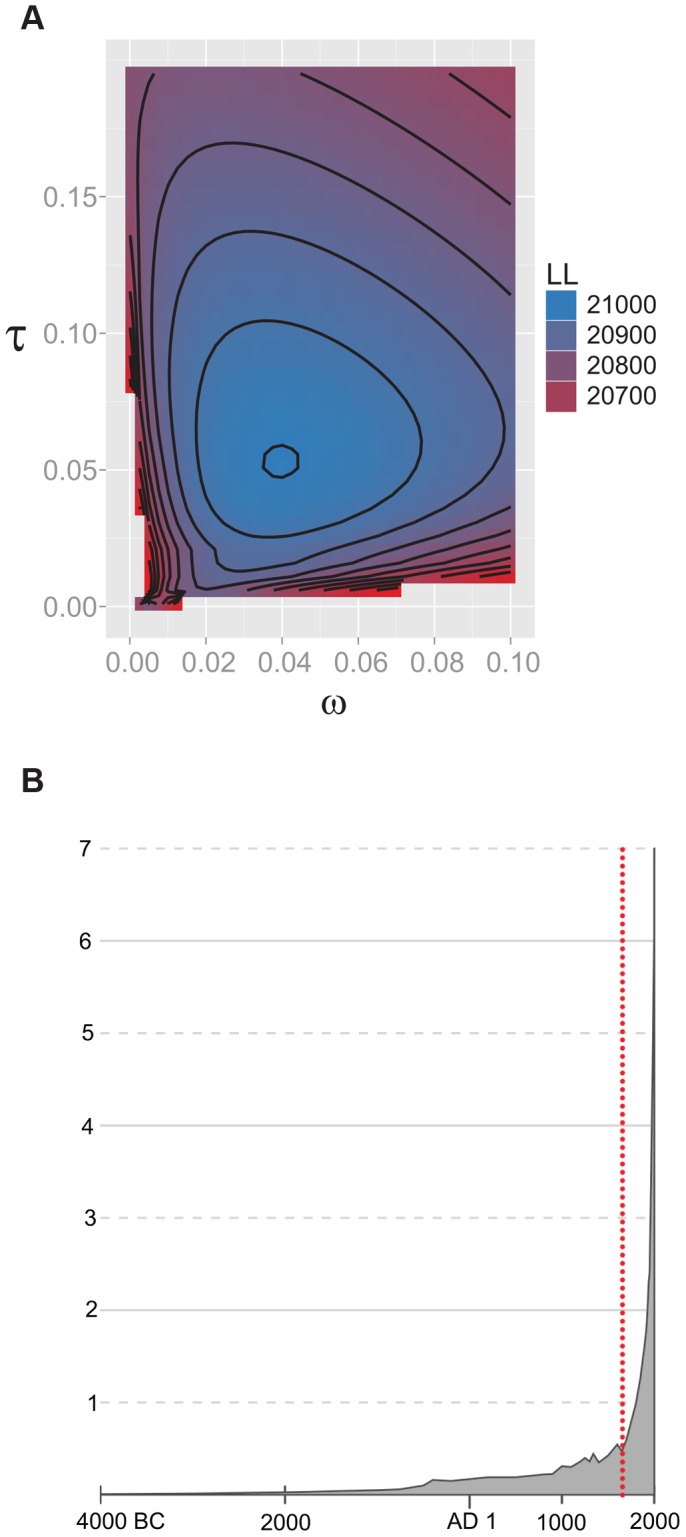
A) Heatmap of likelihoods: demographic inference.Heatmap of log10 likelihood values over a grid of values for two demographic parameters: τ = generations since expansion/Ne (Y axis) and ω = Nanc/Ne (X axis) where Nanc is the effective size of the ancestral population prior to expansion and Ne is the effective size of the current population. Log10 likelihood (LL) values of the data given various parameter values are indicated on the color key. There is a well demarcated peak in likelihood values. B) Historical growth of human and M.tb populations. Historical patterns of growth of human populations are shown in the gray curve, with calendar years on the X axis and size of global human population in billions on the Y axis. Data and image from http://en.wikipedia.org/wiki/World_population. The estimated timing of expansion of the global M.tb population is shown as a red dotted line (instantaneous expansion model, see text).